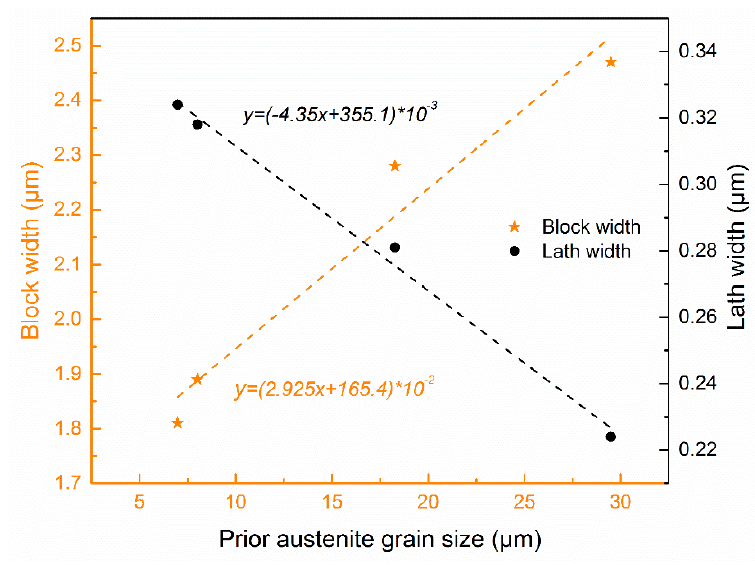
Figure 7. Dependence of block width and lath width on prior austenite grain size in MCLA steel.